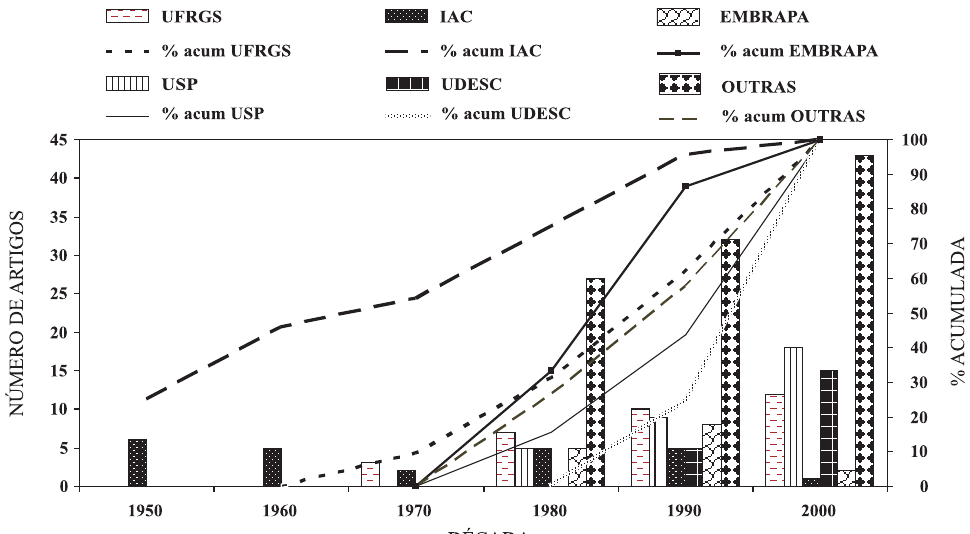
Figura 1. Produção científica (número de artigos e percentagem acumulada) sobre erosão acelerada do solo das principais instituições brasileiras ao longo do